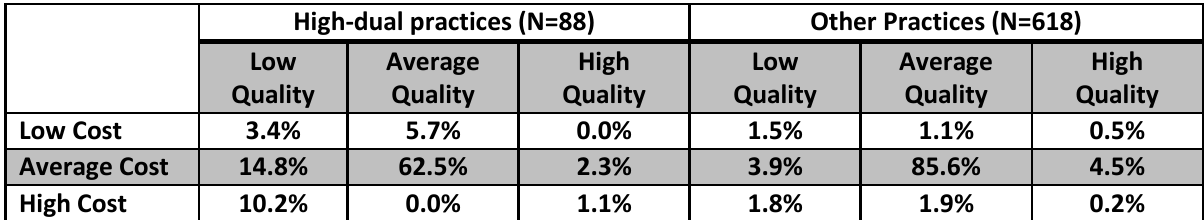
Table 10.13a: Value Modifier by High-Dual Practice vs. Other Practice